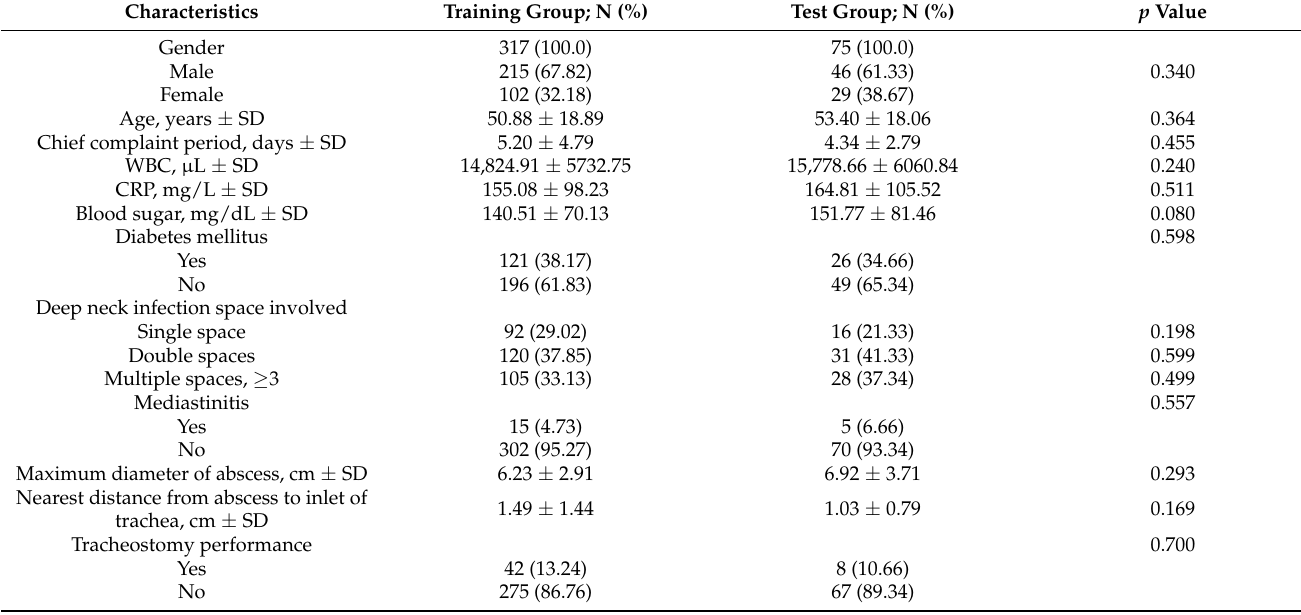
Table 2. Clinical and computed tomography data of the training and test